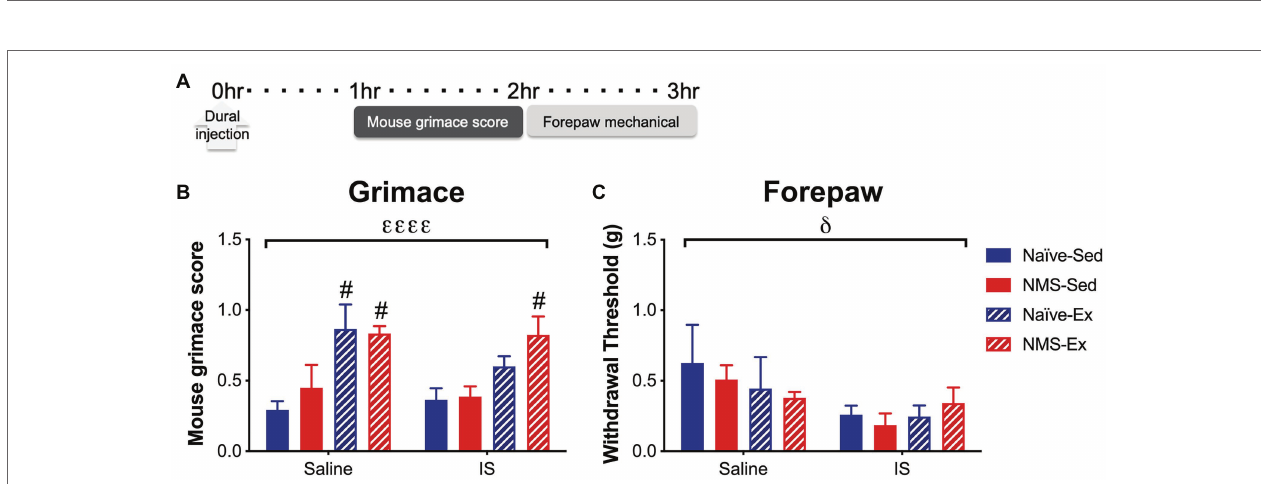
FIGURE 4 | Inflammatory soup or saline was applied to the dura through a modified injection cannula of Sed or Ex naïve and NMS mice. (A) MGS was measured every 5 min for 1 h beginning 1 h after dural injection. Forepaw mechanical thresholds were measured immediately after. (B) An overall significant effect of exercise was observed on MGS, such that naïve-Ex-Saline, NMS-Ex-Saline, and NMS-Ex-IS mice all had significantly higher MGS compared to their sedentary counterparts. (C) A significant overall effect of IS was observed on forepaw mechanical withdrawal threshold. Bracket indicates a significant effect of exercise ( εεεε p < 0.0001) or IS ( δ p < 0.05), three-way ANOVA; # p <0.05 vs. sedentary, Fisher’s LSD posttest. n =